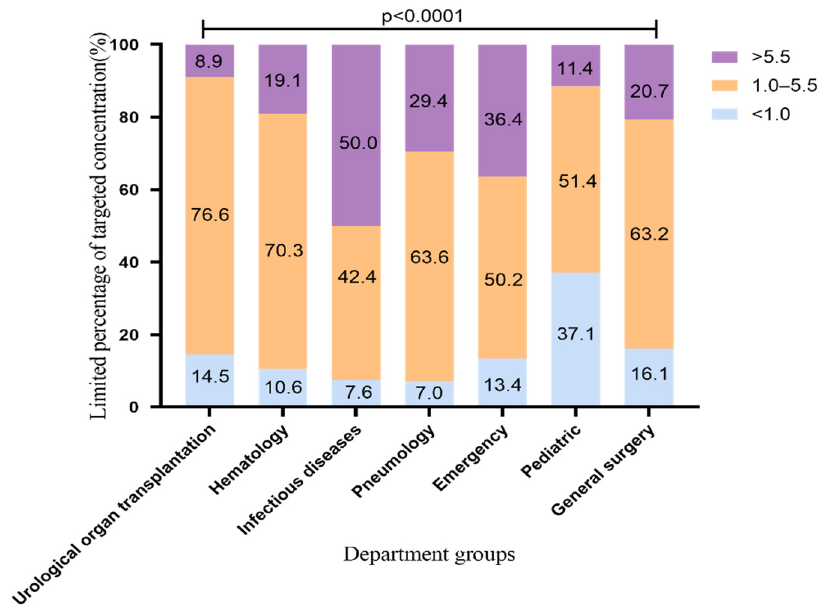
Figure 2. Distribution of VRZ concentration using VRZ 200 mg q12h (2183 blood samples). The data represent the percentage.